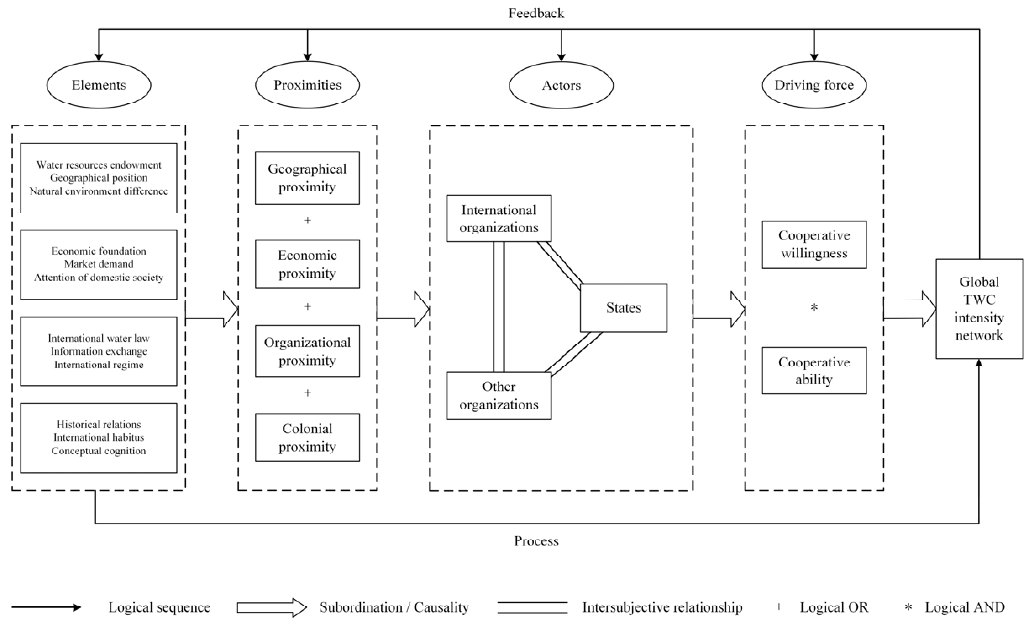
Figure 1. The theoretical framework for the formation of global TWC.